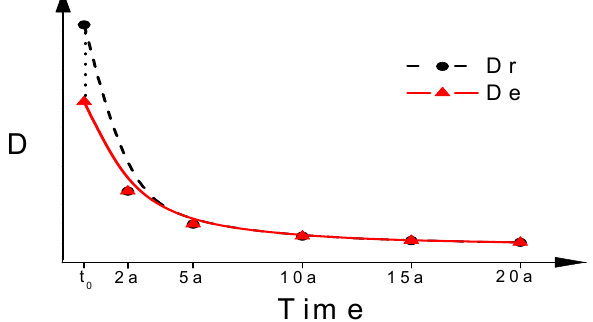
Figure 4. Relationship between diffusion coefficient of RCM and exposure test.